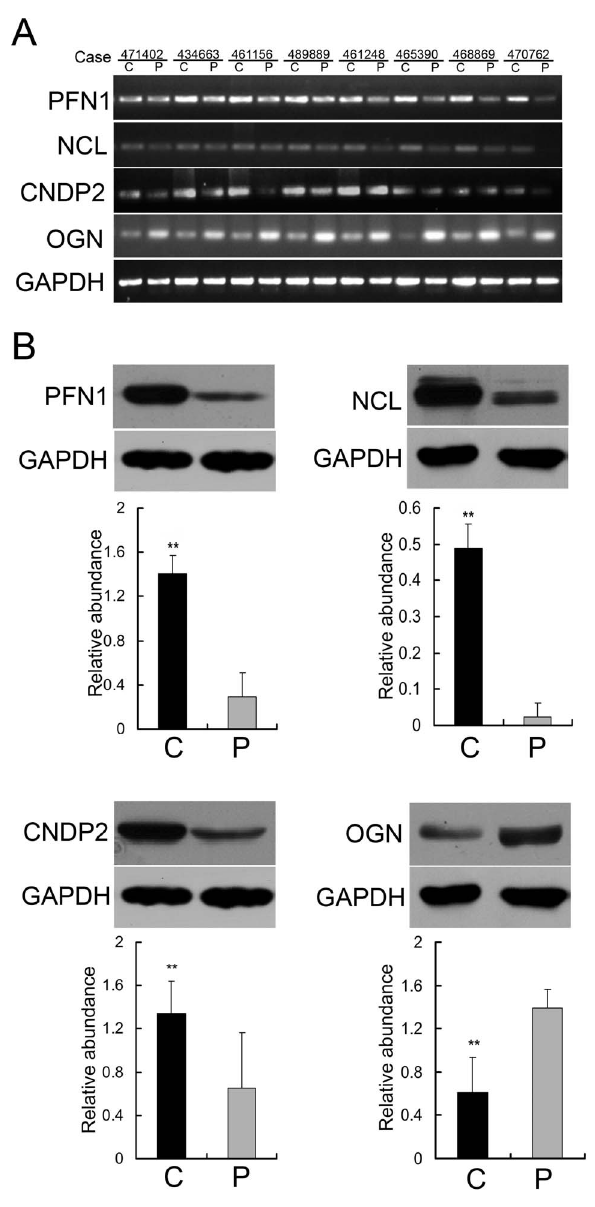
Figure 4. Validation of differentially expressed proteins in laryngeal carcinoma tissue and the adjacent normal tissue by semiquantitative RT-PCR and Western blotting. (A) The repre- sentative image of mRNA levels of PFN1, NCL, CNDP2 and OGN between laryngeal carcinoma tissue and their corresponding normal tissue in 8 cases of tissues measured by semiquantitative RT-PCR. (B) The representative result of Western blotting show the expressions of PFN1, NCL, CNDP2 and OGN in the laryngeal carcinoma tissue and the adjacent normal tissue, respectively. Histograms are representative the relative abundance of proteins mean from 24 cases of tissues. (**P , 0.01 by One-way ANOVA).